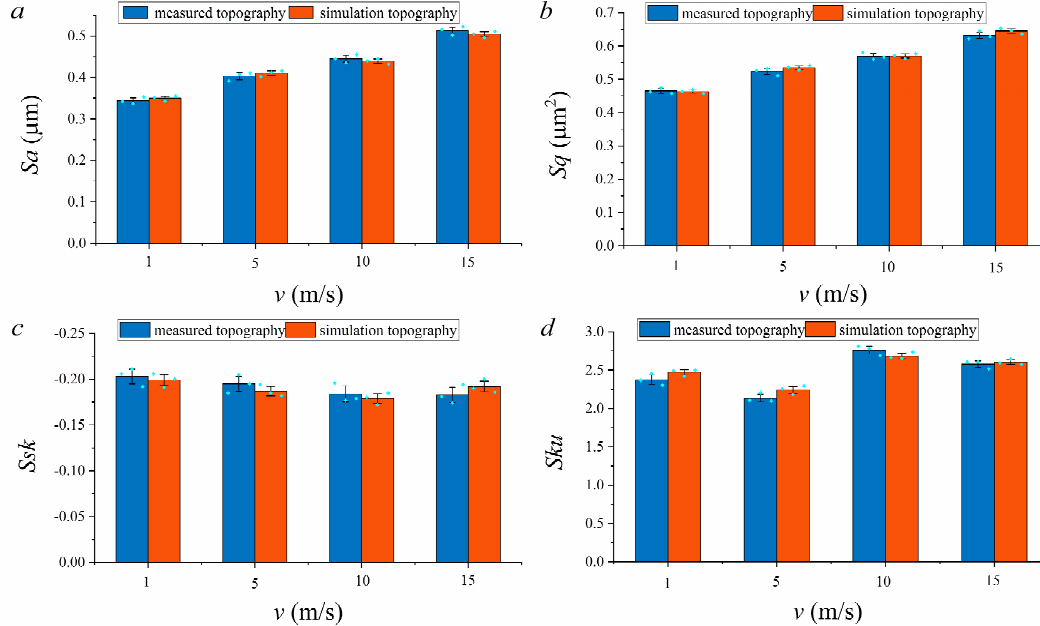
Figure 12. Comparison results of roughness parameters. ( a ) Sa ; ( b ) Sq ; ( c ) Ssk ; ( d ) Sku .